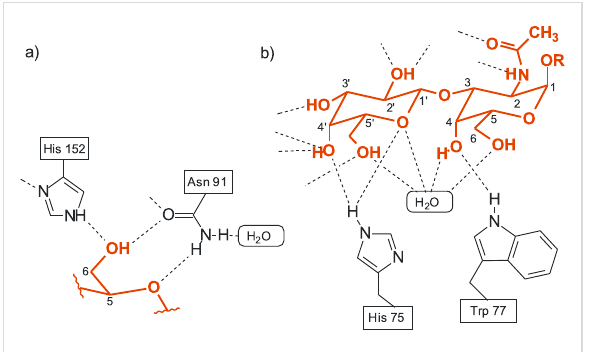
Figure 1: Examples of hydrogen bonds in the complex of a) galactose- binding protein with D-glucose [3], b) Amaranthus caudatus agglutinin with Galβ3GalNAc [1].